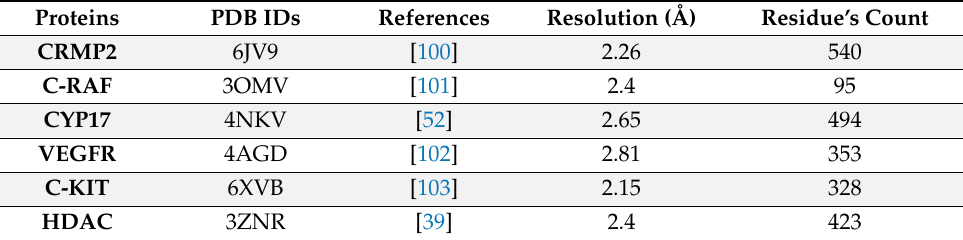
Table 1. PDB IDs, atomic resolutions and number of residues of target proteins used in the cur- rent